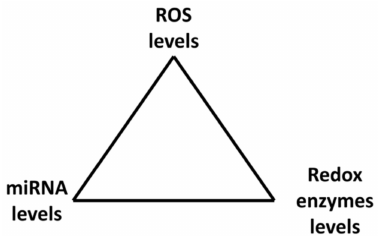
Figure 4. Mutual regulation of miRNAs and ROS through regulation of redox